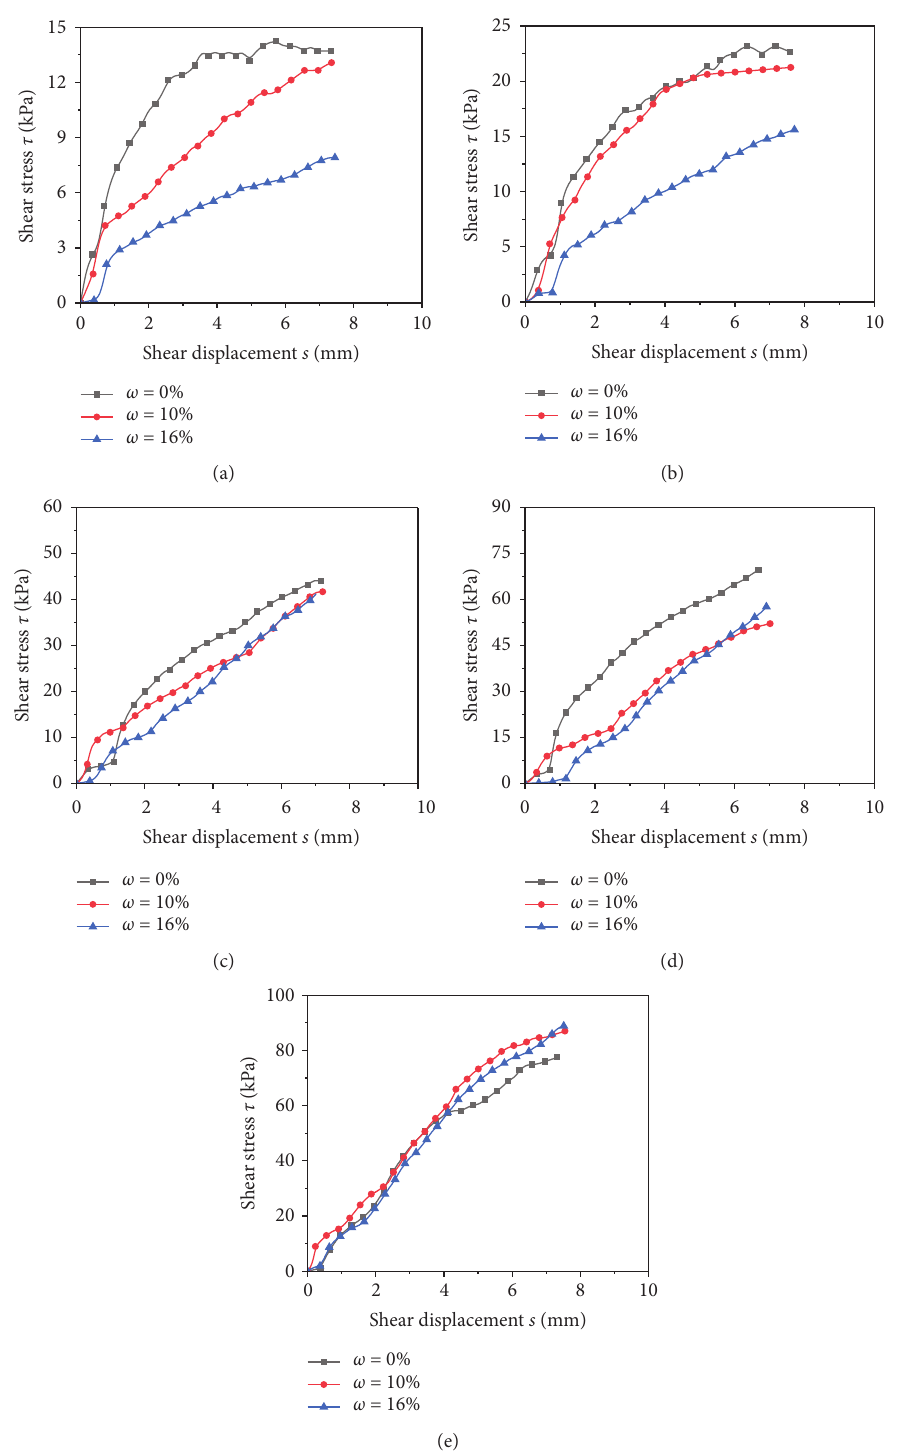
Figure 7: Shear stress versus shear displacement with different water contents. (a) Vertical pressure 50kPa, (b) vertical pressure 100kPa, (c) vertical pressure 200kPa, (d) vertical pressure 300kPa, and (e) vertical pressure